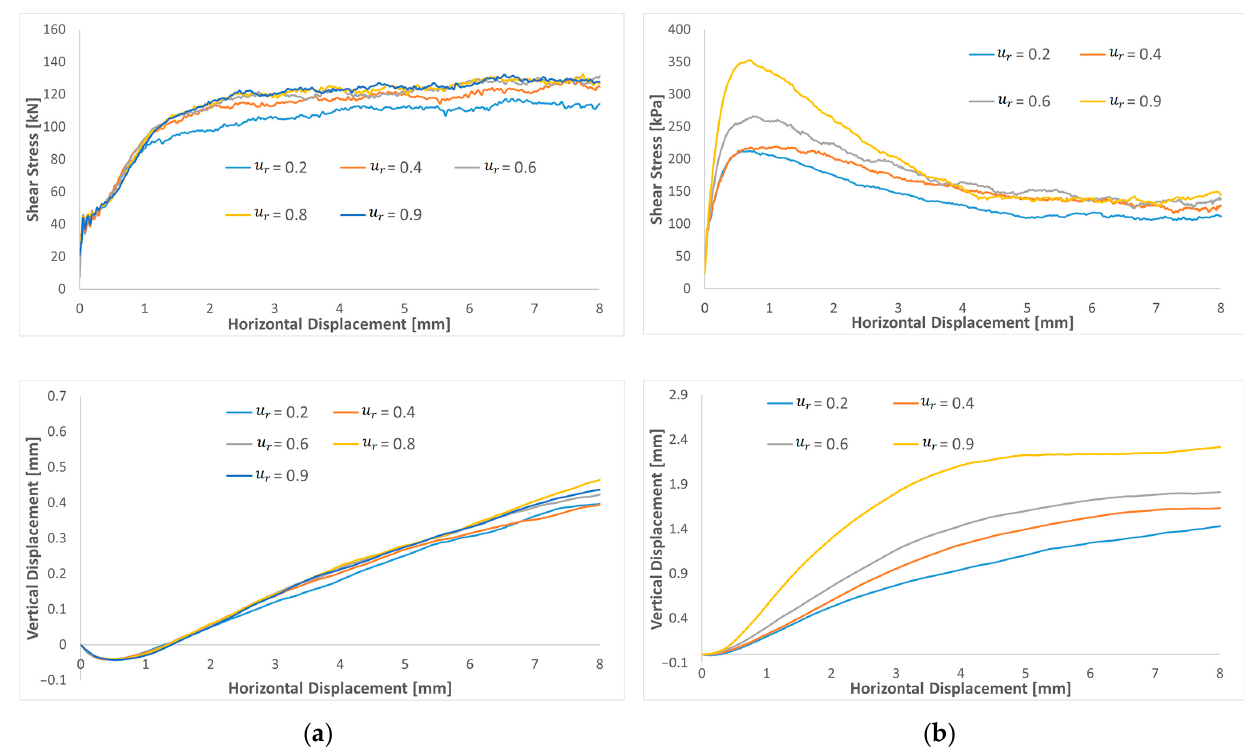
Figure 8. Shear stress and dilatation curves of varying rolling resistance coefficient for a low and a high friction: ( a ) µ (cid:3404) 0.2 and ( b ) µ (cid:3404) 0.6 .